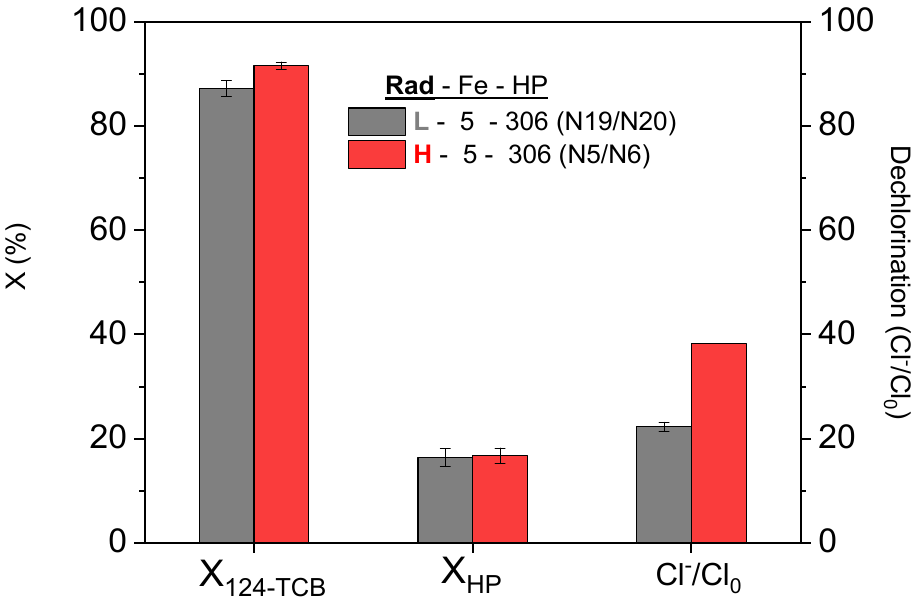
Figure 1. Effect of the irradiation level on the conversion of 124-TCB and HP and dechlorination de- gree achieved after 180 min of reaction. Experimental conditions: Fe = 5 mg L − 1 , H 2 O 2 = 306 mg L − 1 , 124-TCB = 28 mg L − 1 , Low rad intensity (L), and High rad intensity (H).